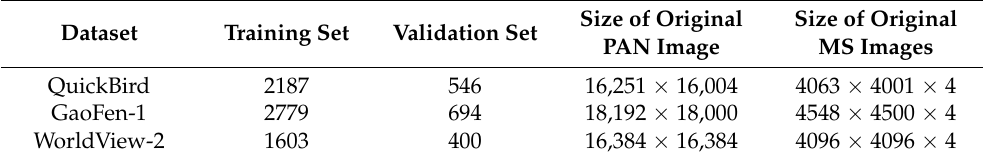
Table 1. Size of training and validation sets for GaoFen-1, QuickBird, and WorldView-2. Dataset